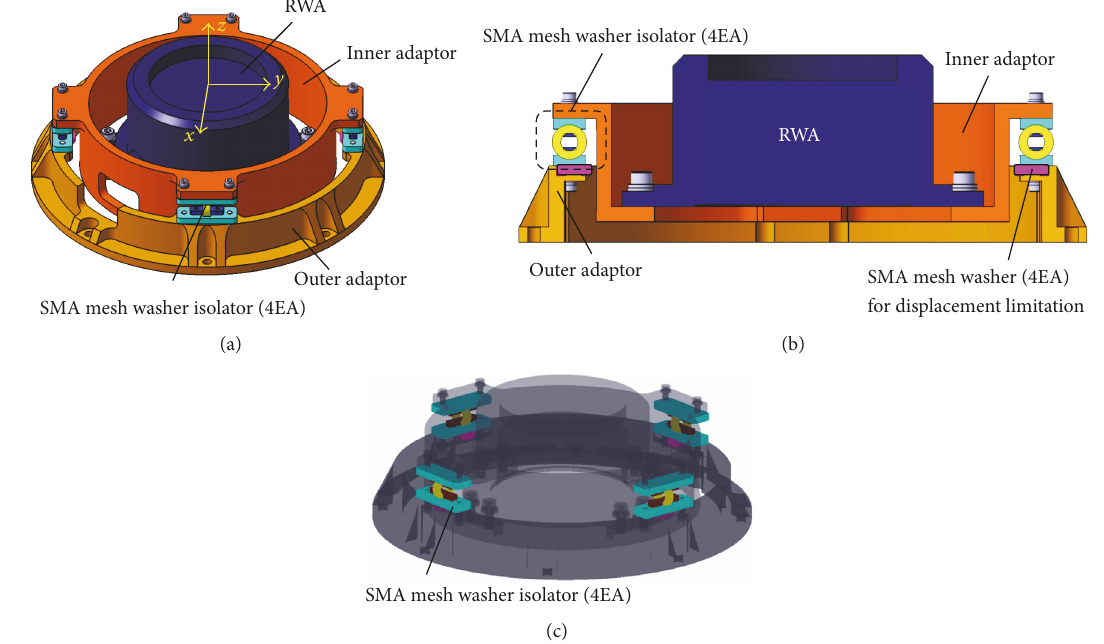
Figure 7: Configuration of the RWA combined with the ring-type SMA mesh washer passive isolation system ((a): isometric view, (b): sectional view, and (c): real configuration of the RWA isolation